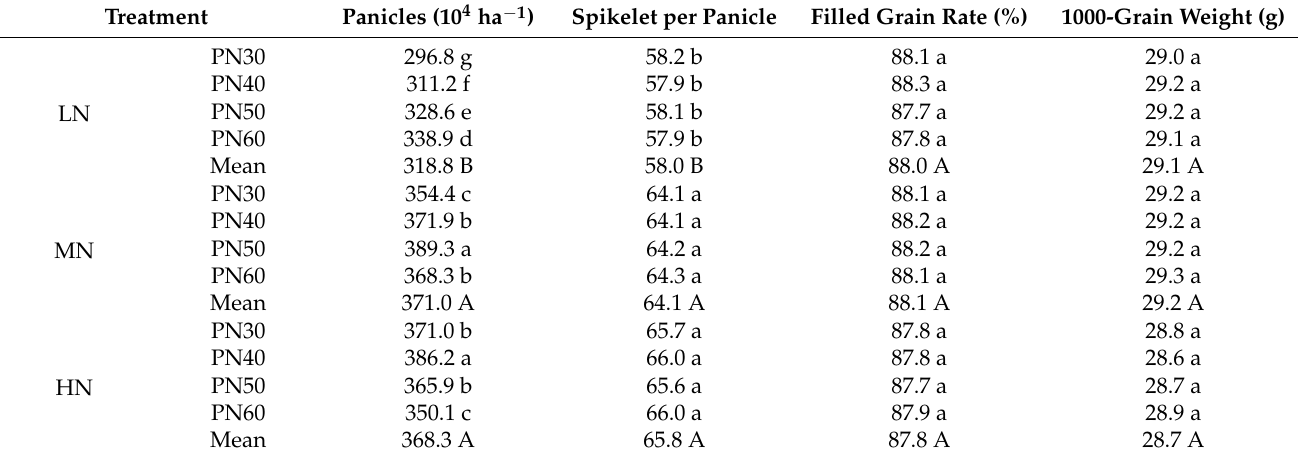
Table 4. Effects of N regime in the main crop on the yield components of the ratoon crop. Treatment